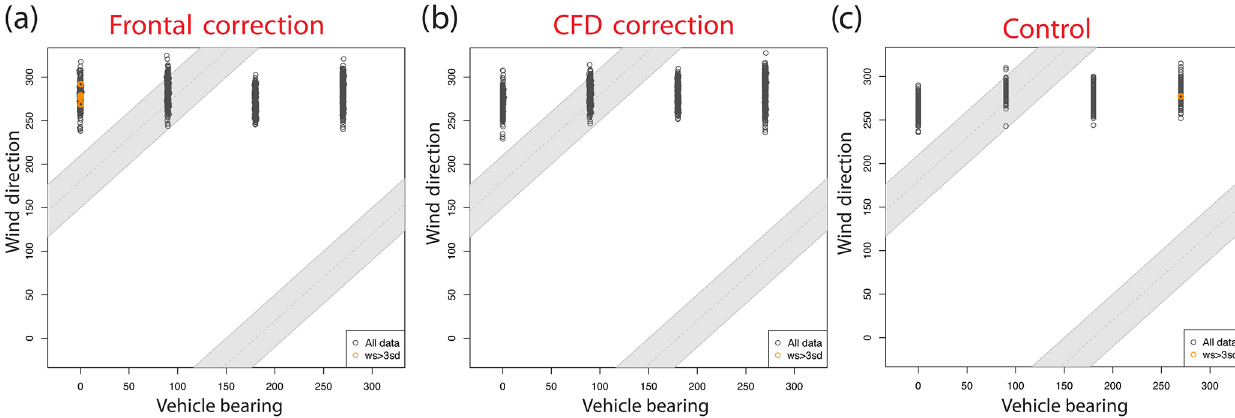
Figure 7. Distribution of wind measurements across vehicle bearing with (a) frontal correction applied to mobile measurements, (b) em- pirical correction and frontal correction applied to mobile measurements, and (c) stationary measurements. The shaded grey bars represent measurements acquired when the vehicle was driving in tailwind conditions. The yellow circles represent wind speed measurements that are greater than 3 standard deviations away from the mean wind speed of the wind speed measurements calculated with the (a) frontal correction applied and (b) empirical correction and frontal correction applied and that are (c) specific to the stationary anemometer at each